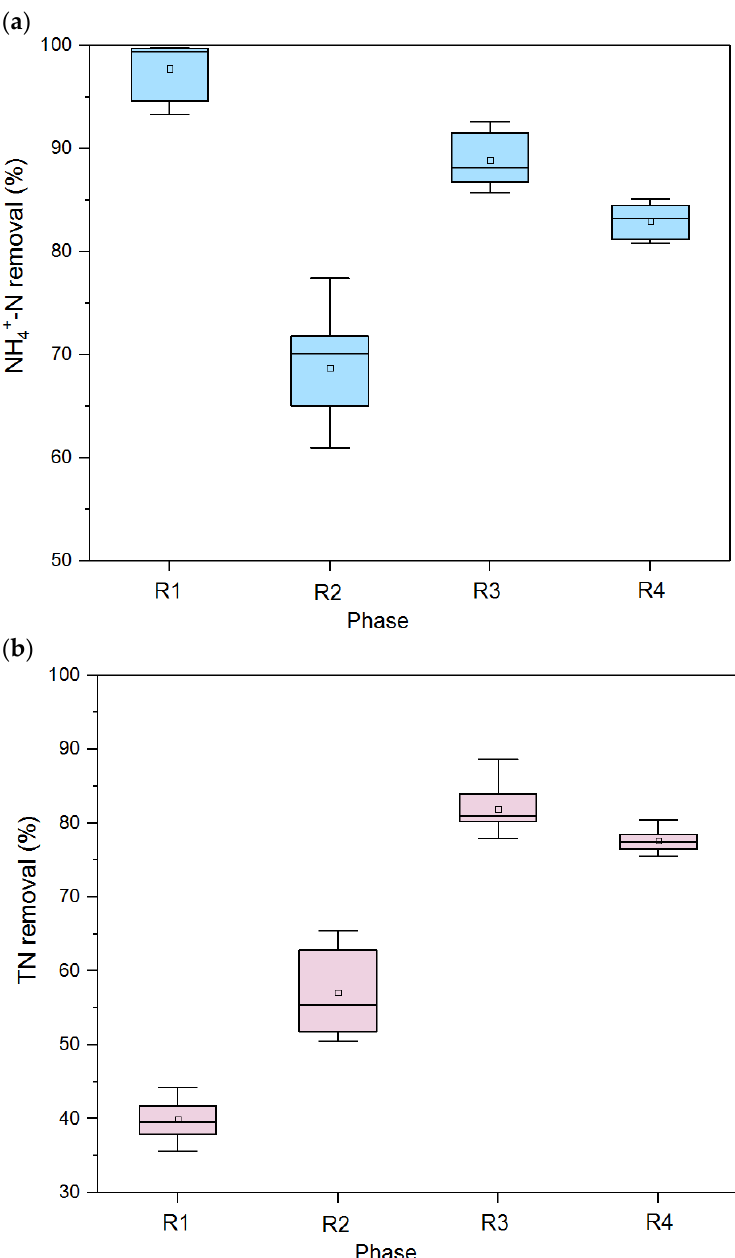
Figure 3. Boxplots of nitrogen removal performance: ( a ) ammonia removal efficiency; ( b ) TN removal efficiency under four scenarios (R1–R4). The box shows 25%, 50%, and 75% percentiles, and the error bar indicates 5% and 95% percentiles.